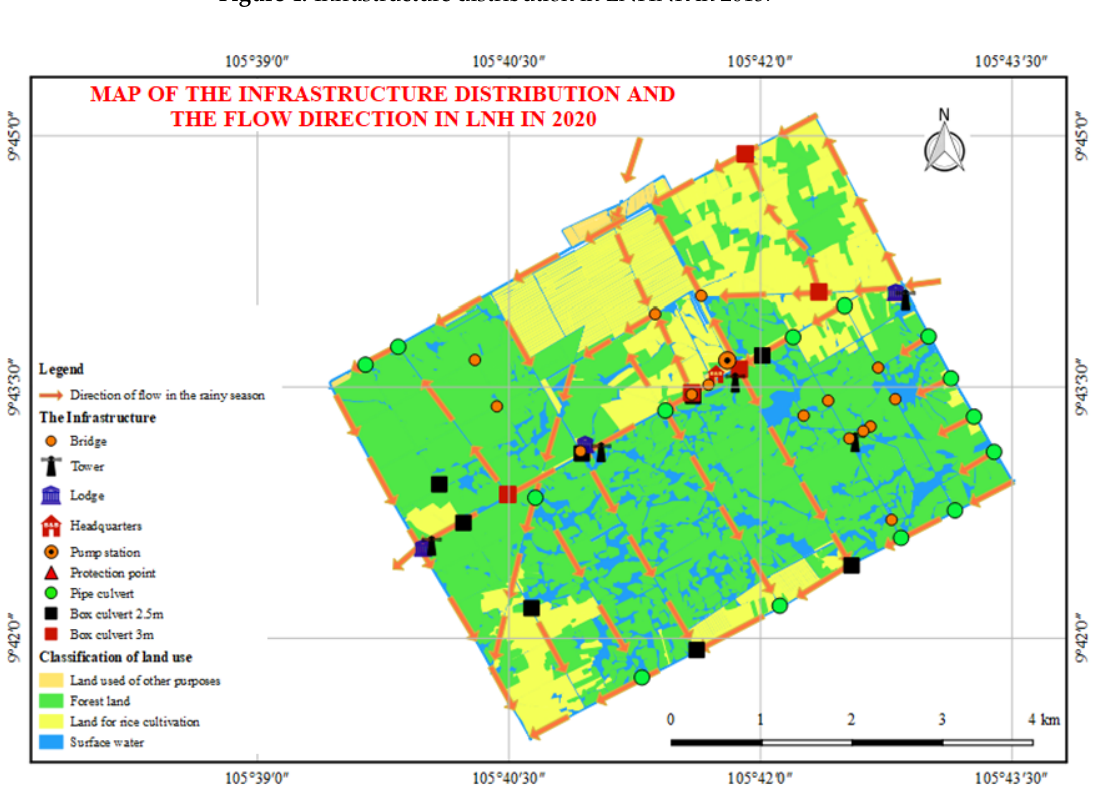
Figure 5. Map of the infrastructure distribution and the flow directions in LNHNR in 2020.